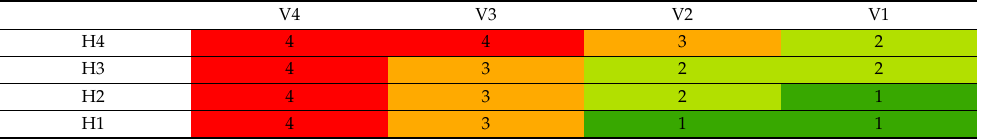
Table 3. V SLOPE deformation rate level combined with the landslide hazard assessment level